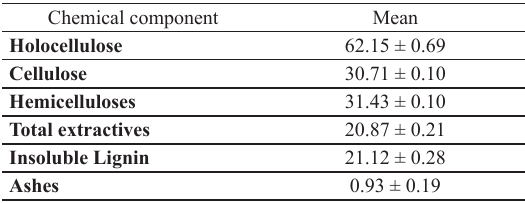
Table 2. Sugarcane bagasse chemical